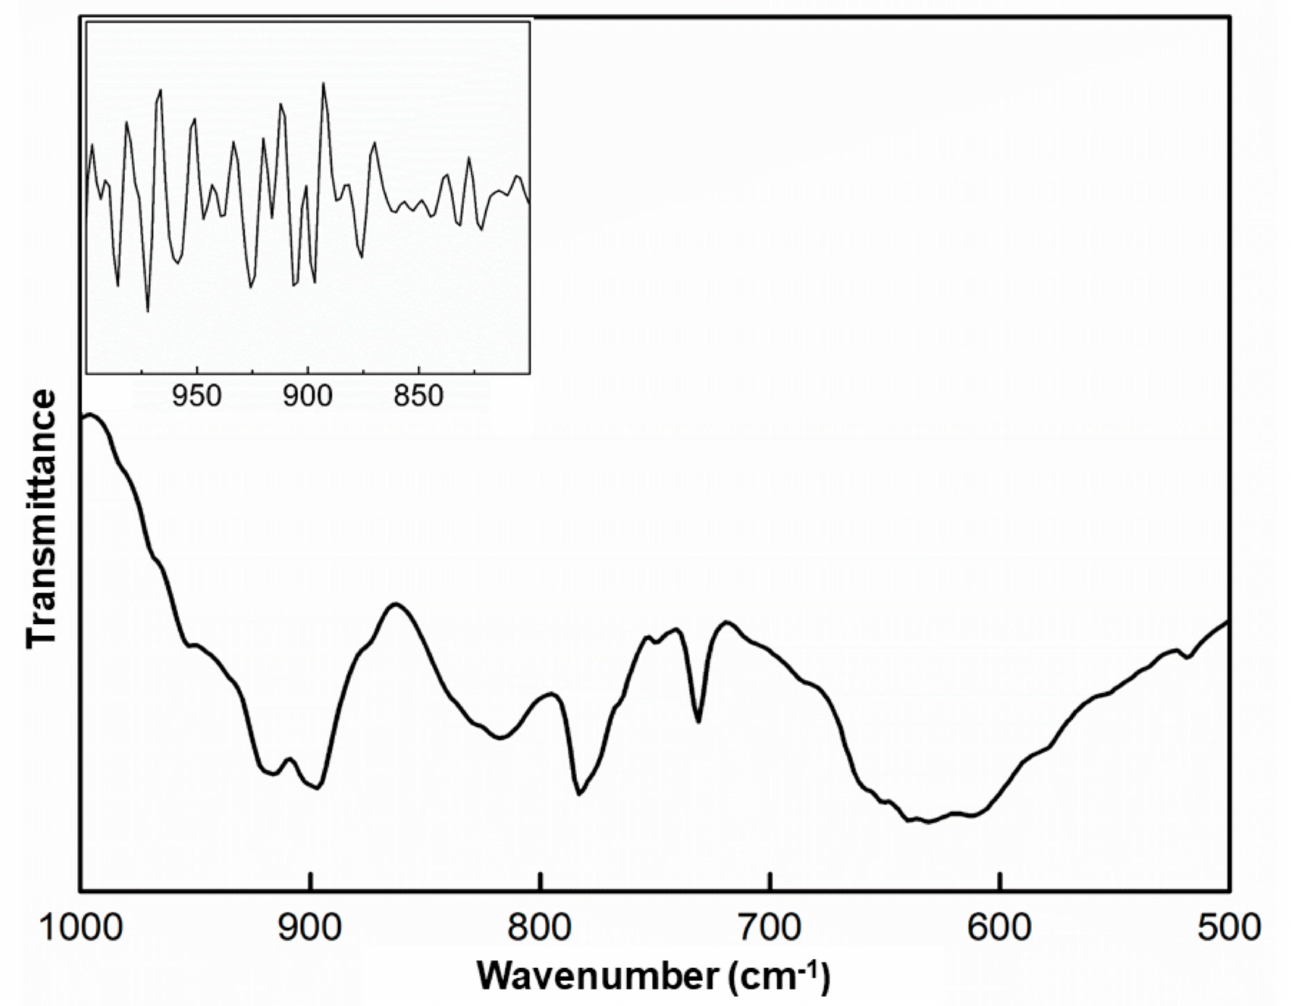
Figure 4. FTIR spectrum of Compound 1 in the 500–1000 cm − 1 region. The inset shows the second derivative spectrum in the region 800–1000 cm − 1